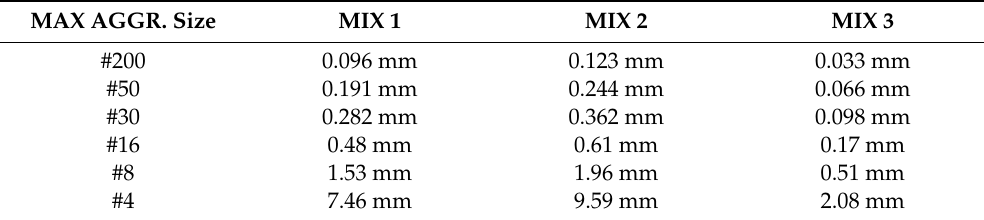
Table 11. Required thickness of an individual layer to be considered to be the lubrication layer in the interface